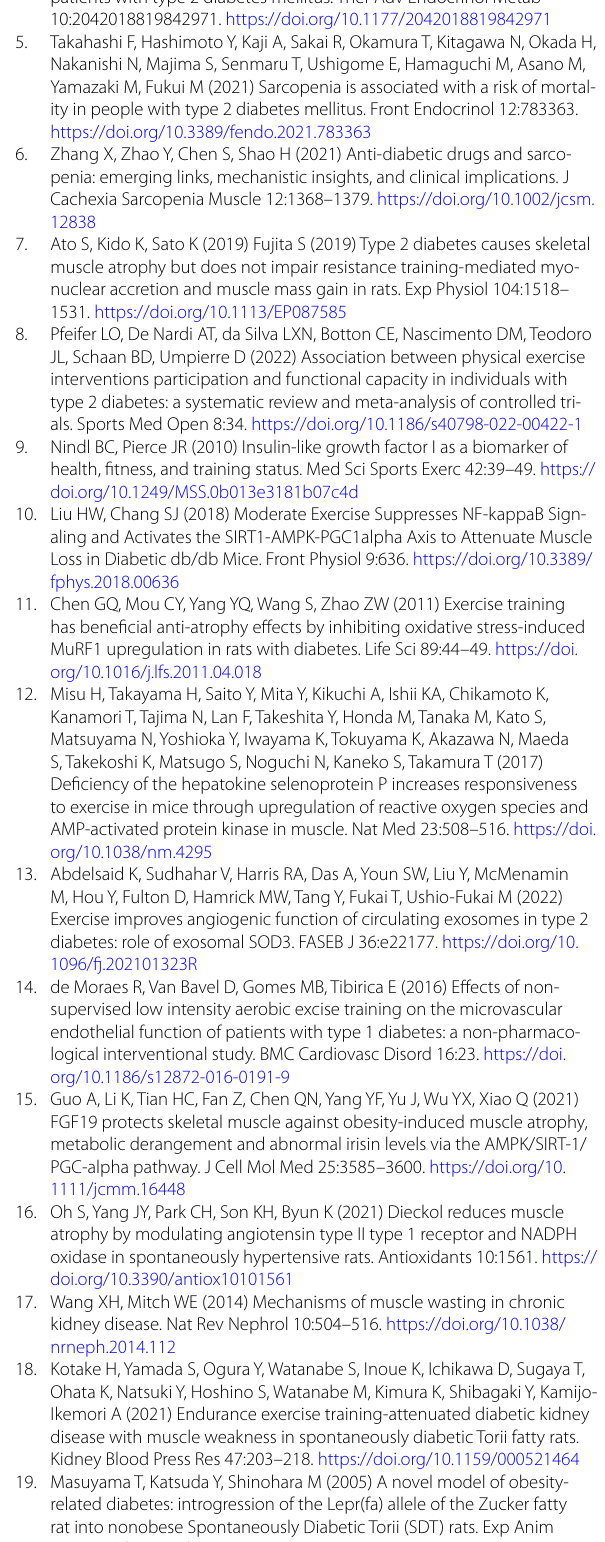
main figures. Figure S10 Western blot analysis of p‑eNOS in EDL (a) and soleus (b) muscles, eNOS in EDL (c) and soleus (d) muscles, and α‑tubulin in EDL (e) and soleus (f) muscles on the same membrane in each group. Red lines represent the edge of each cut membrane. Red boxes show the regions of the original blots used in main